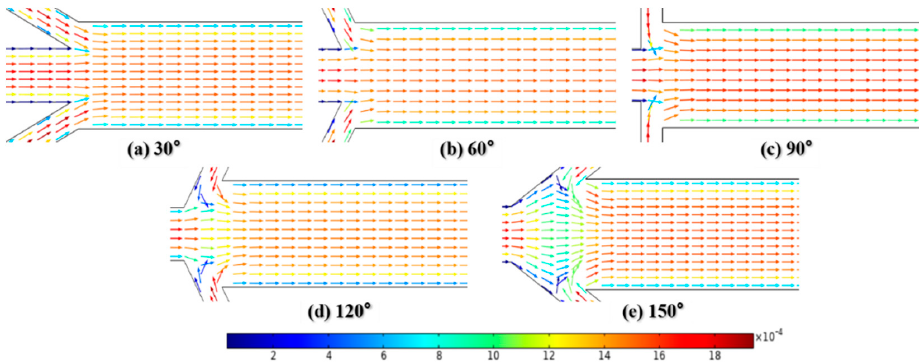
Figure 14. The diffusion lengths with different inflow angles.